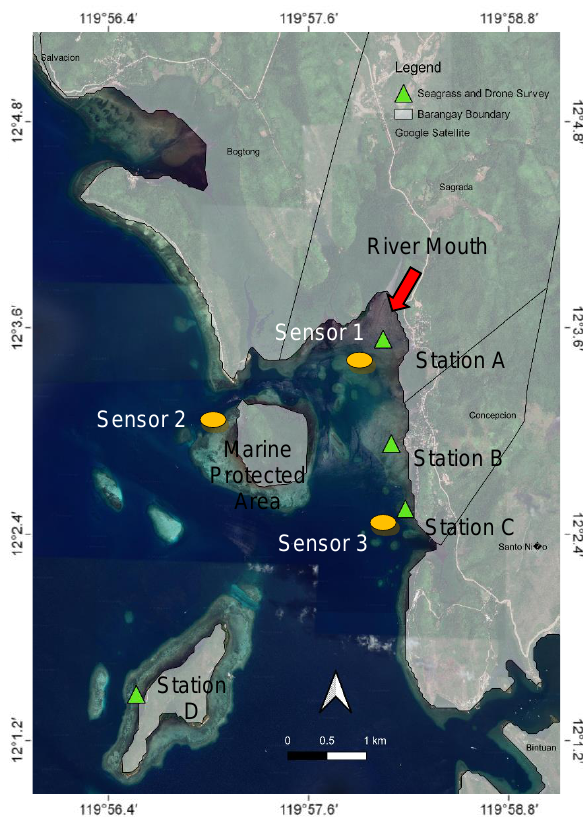
Figure 1. Location of SAV surveys (A, B, C, D), UAV surveys (A, B, C, D) and sensor deployments (1, 2, 3)